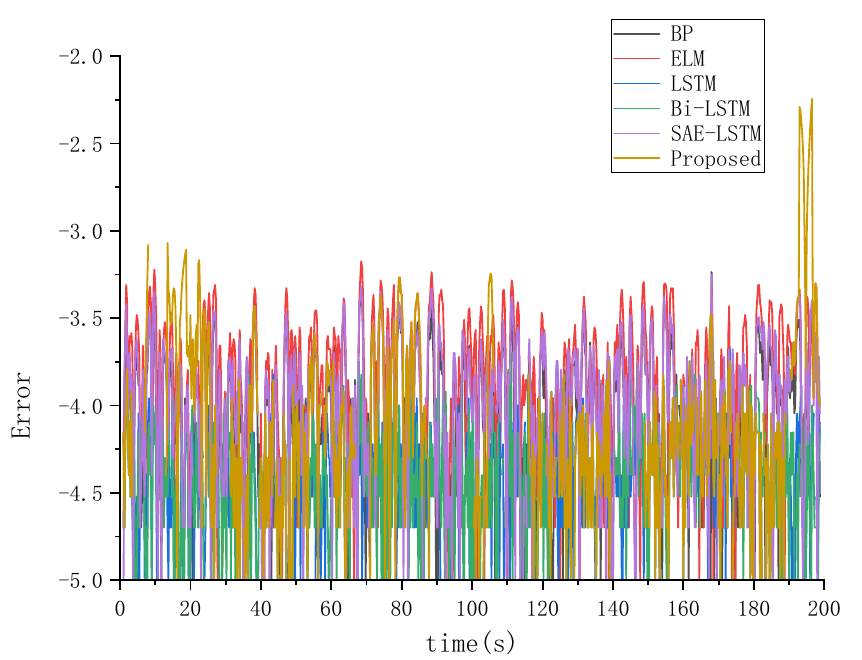
Figure 14. Roll angle prediction error results in the training set of Dataset 1.